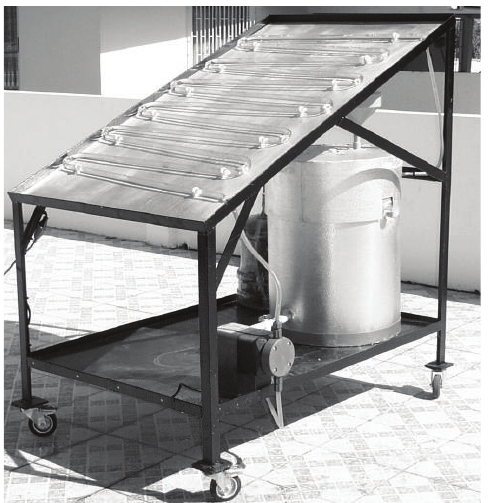
Figure 3: Photograph of solar photochemical reactor installed and in operation, North-East, Trinidad, West